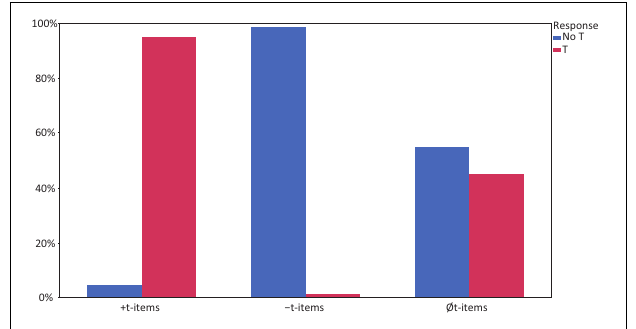
FIGURE 1 | Percent of different responses to the respective categories, “no t” responses are in blue, while “t” responses are depicted in